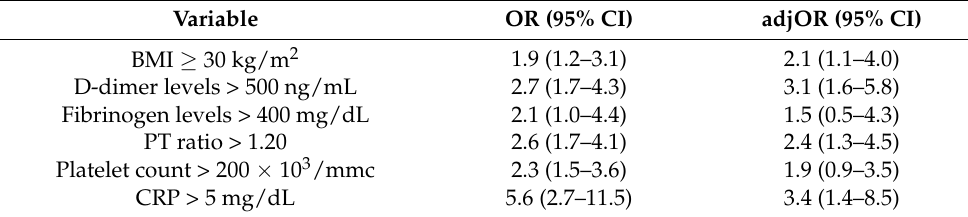
Table 4. Univariate and multivariate logistic regression analysis of potential predictors of %CL > 23% in 287 patients with complete clinical and laboratory data included in the